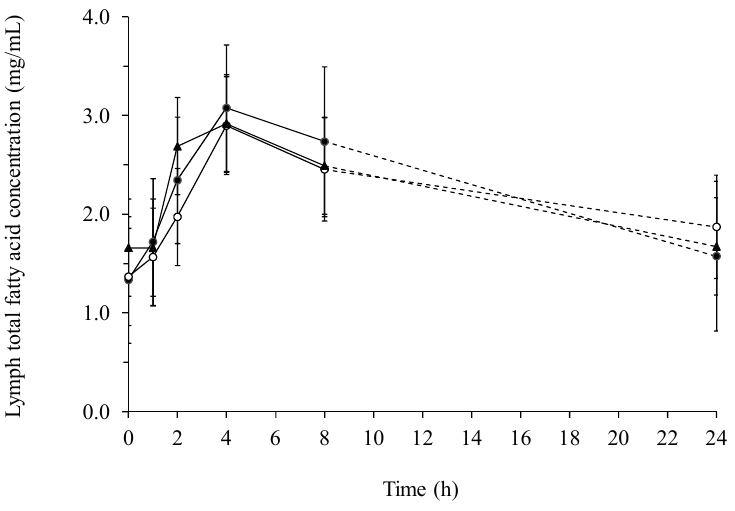
Figure 1. Total fatty acid concentration (mg/mL) in lymph of pigs fed a β -glucan free basal diet ( ● ) or diets supplemented with either barley ( ○ ) or yeast ( ▲ ) β -glucan.